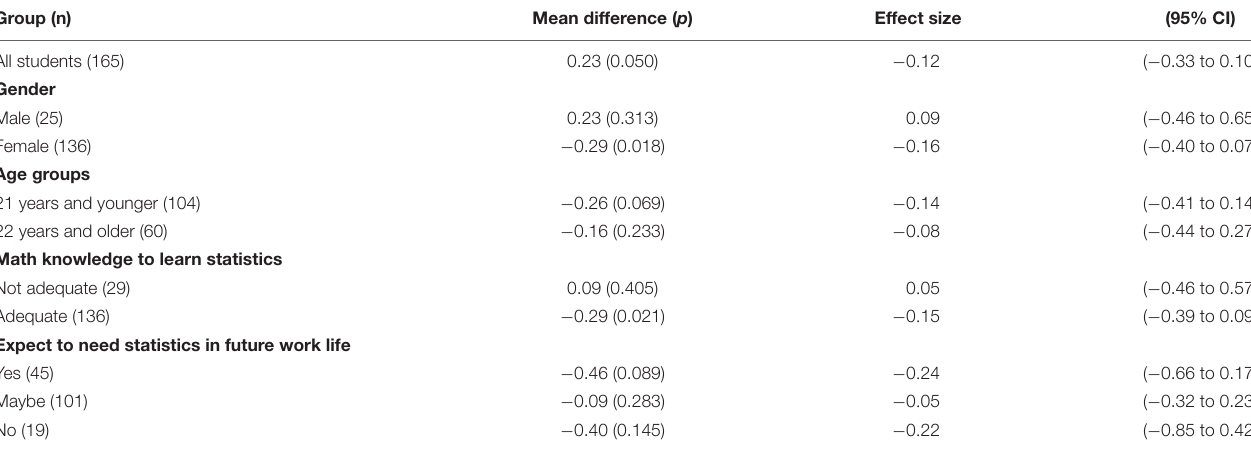
TABLE 4 | Overall and stratified mean differences in critical thinking and effect sizes over